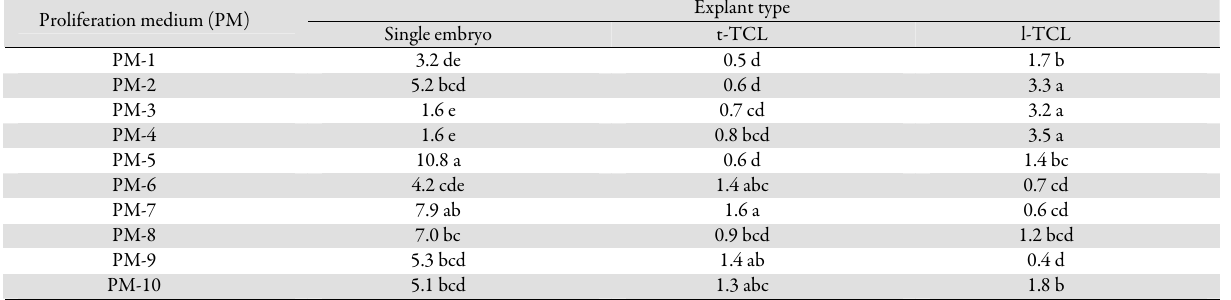
Table 2. Interaction effect of explant types and proliferation media on the number of embryos produced per explan